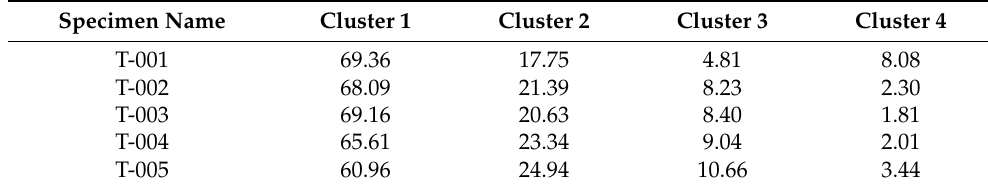
Table 5. Percentage of AE signals in each cluster.